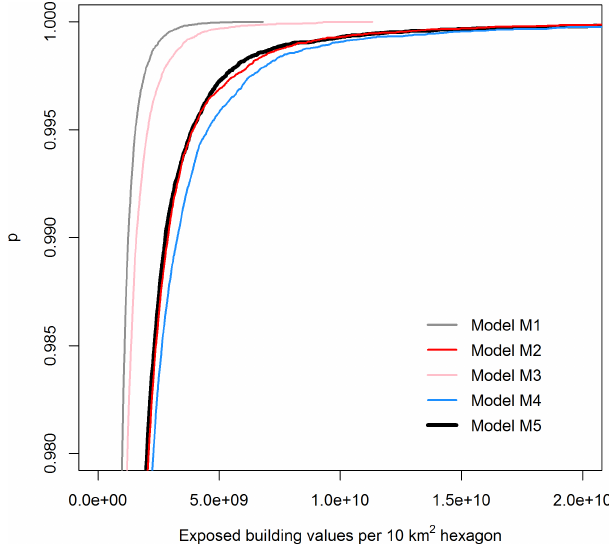
Figure 6. Empirical cumulative distribution function of flood- exposed-building values aggregated to hexagons with a surface area of 10km 2 . Cumulative probabilities ( p ) are generated by 10 5 ran- dom values from GPD with the parameters shown in Table 7. To improve the readability, only probabilities over 98% are